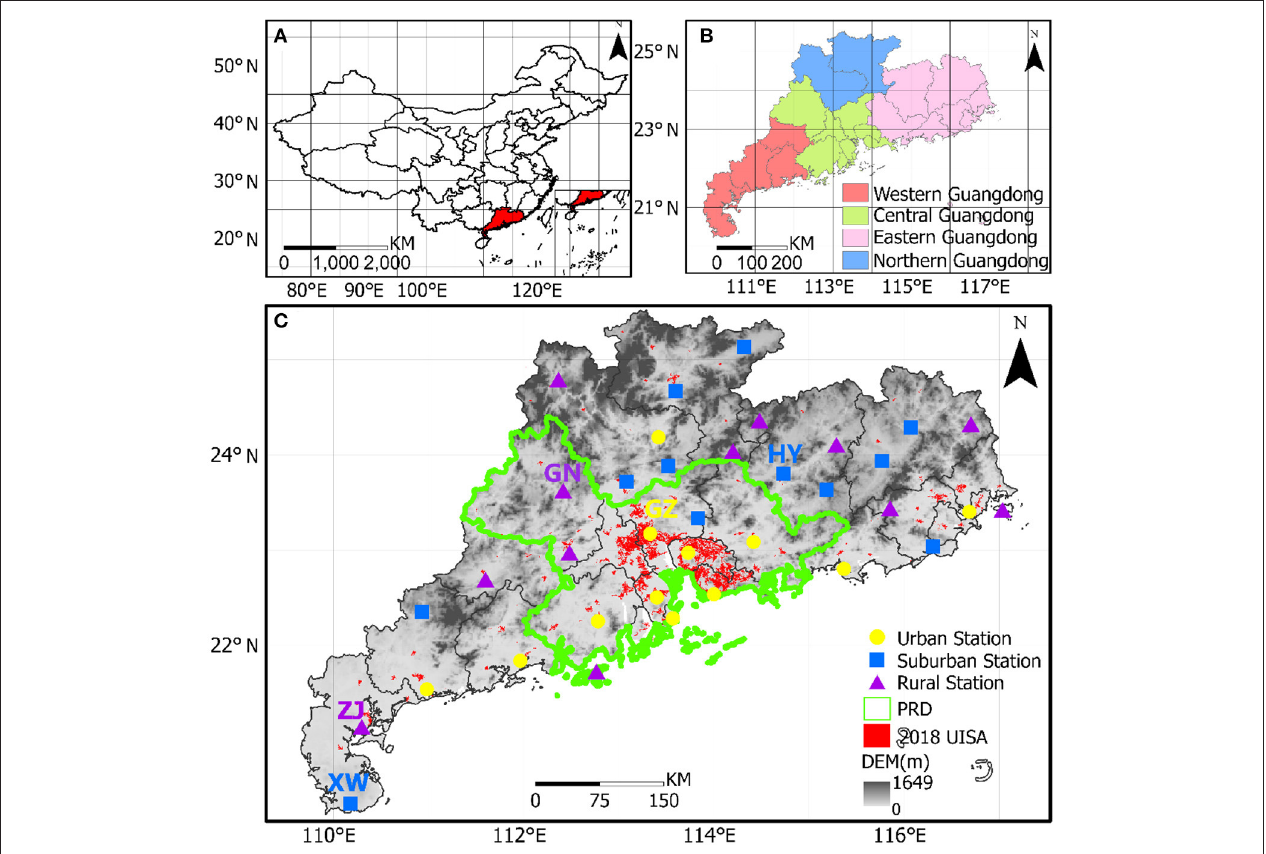
FIGURE 1 | (A) Geography of Guangdong Province. (B) Four sub-regions of Guangdong Province. (C) Distribution of urban, suburban and rural stations in Guangdong Province (superimposed on impermeable-surface data for 2018);